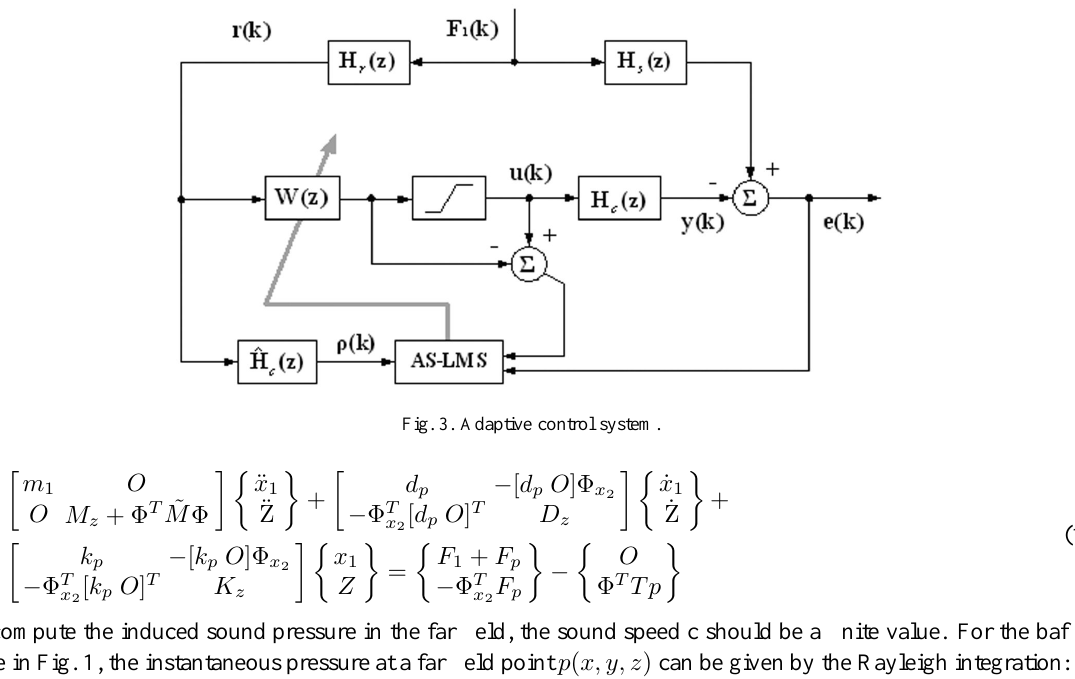
Fig. 3. Adaptive control